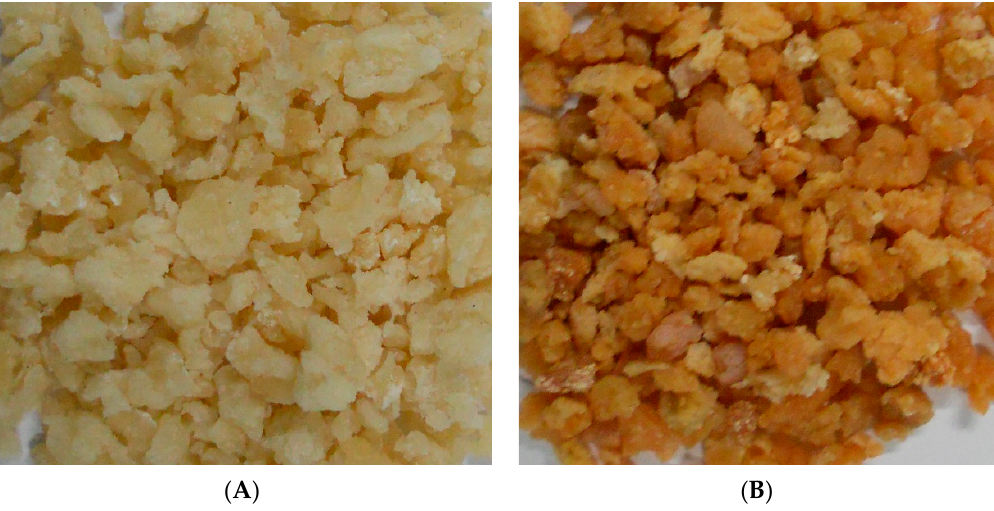
Figure 4. Comparison of Qula color from solar drying ( A ) and open sun-drying ( B ). The L * , a * , and b * values of Qula were also measured and are important color evaluation indexes for dairy products. The L * value is whiteness or brightness. A large L * indicates a bright sample. The a * value is redness or greenness. An increase in a * denotes a redder chroma, which is indicative of browning reaction. The b * value is yellowness or blueness. A large b * value indicates a yellower sample [51]. As shown in Figure 5E, the color